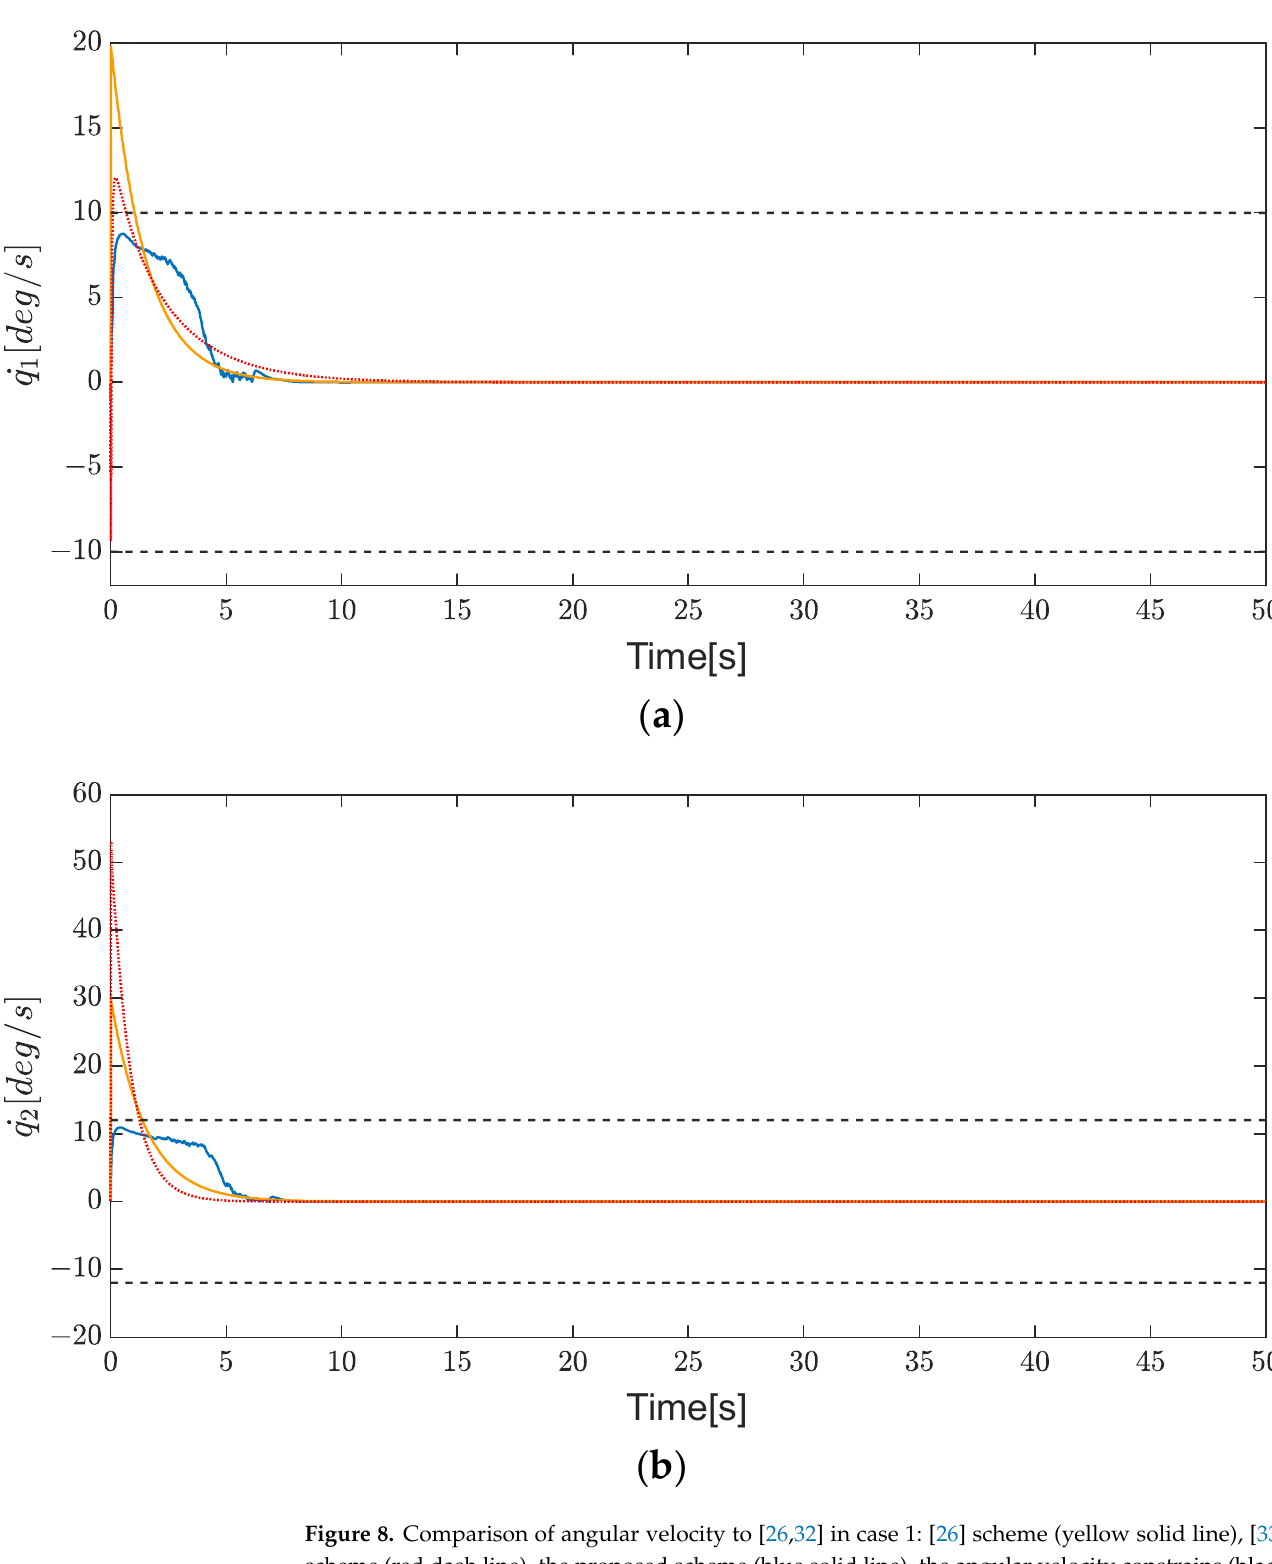
Figure 8. Comparison of angular velocity to [26,32] in case 1: [26] scheme (yellow solid line), [33] scheme (red dash line), the proposed scheme (blue solid line), the angular velocity constrains (black dashed line); ( a ) Joint 1. ( b ) Joint 2.